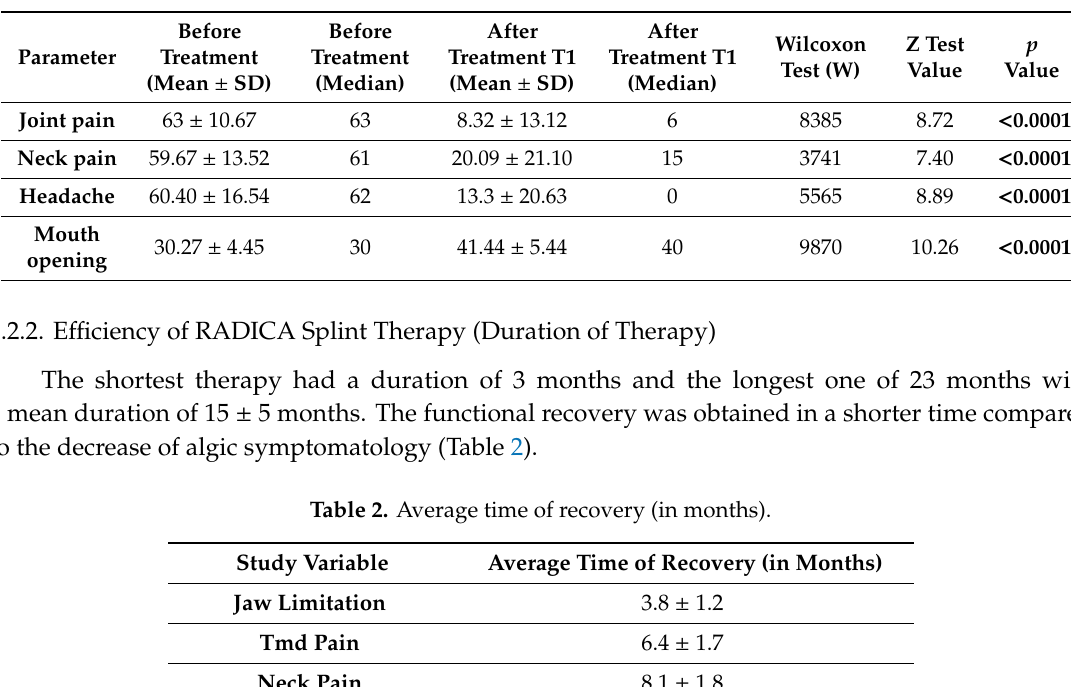
Figure 3. Results of treatment with the RA.DI.CA. splint at T1. (%) Patients for each category. Table 1. Changes in pain symptomatology (according to verbal numeric scale) and mouth opening (in mm) before and after treatment with Wilcoxon test and Z-test, p < 0.05. Bold type = statistically significant.